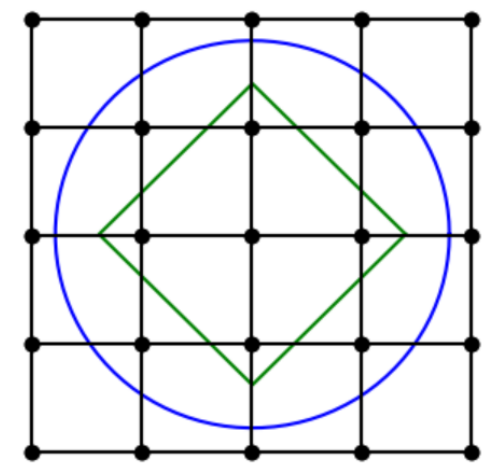
Fig. 4 Free-form deformation of a three-dimensional